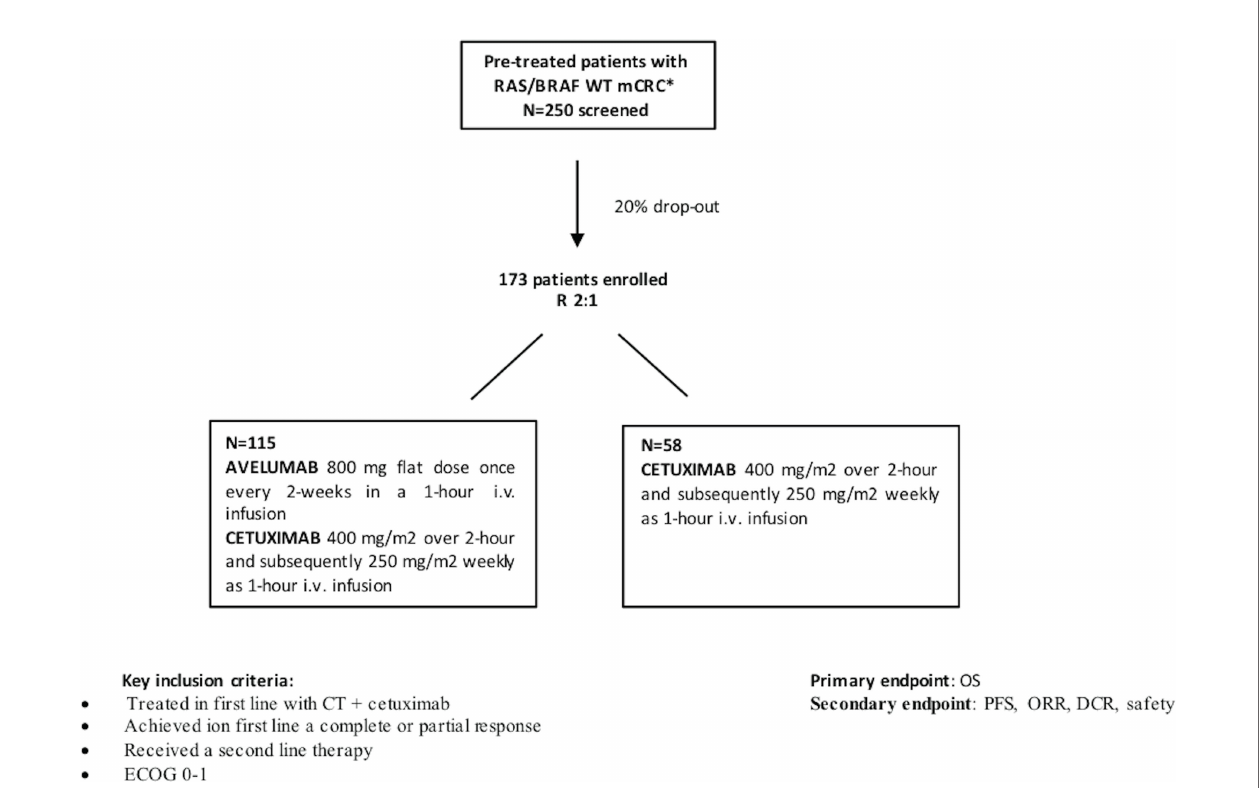
FIGURE 1 | CAVE-2 study